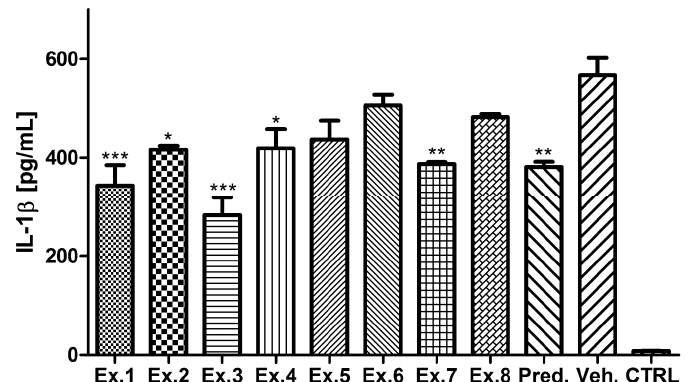
Figure 2. IL-1 β production inhibitory activities of Scorzonera species. The cells were pretreated with extracts 1–8 (Ex. 1–8) (25 μ g/mL), and prednisone (1 μ M), or the vehicle (DMSO) only. After 1 h of the incubation, the inflammatory response was induced by LPS [except of the control cells (CTRL)]. The secretion of IL-1 β was measured 24 h after the LPS addition. The results are expressed as mean ± SE for three independent experiments. * Significant difference in comparison to vehicle only treated cells ( p < 0.05), ** significant difference in comparison to vehicle only treated cells ( p < 0.01), *** significant difference in comparison to vehicle only treated cells ( p < 0.001).